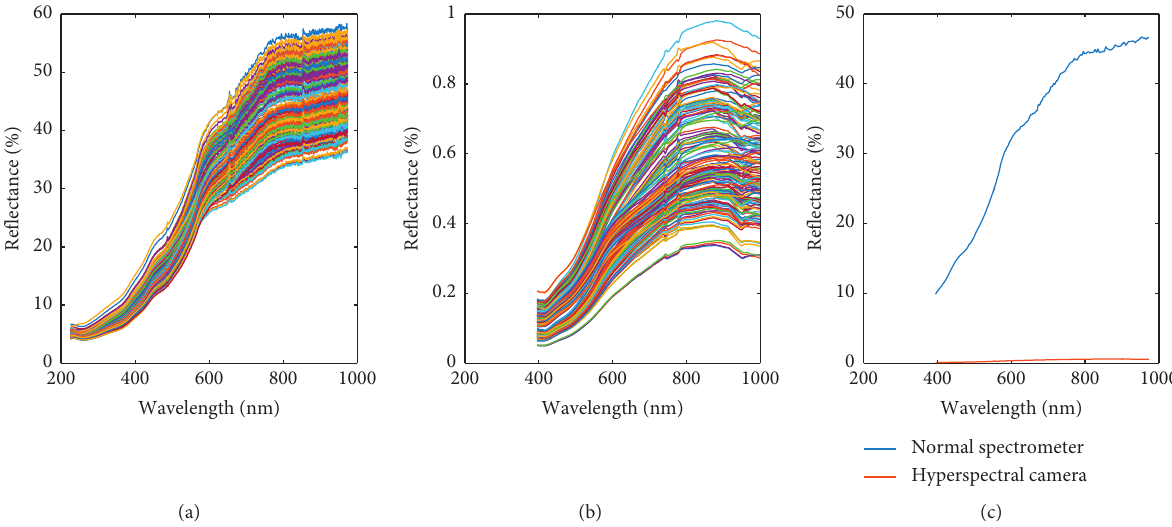
Figure 2: (a) The reflectance spectrum of all soil samples by the normal spectrometer, (b) the reflectance spectrum of all soil samples by the hyperspectral camera, and (c) the average spectra of all soil samples under the two instruments.